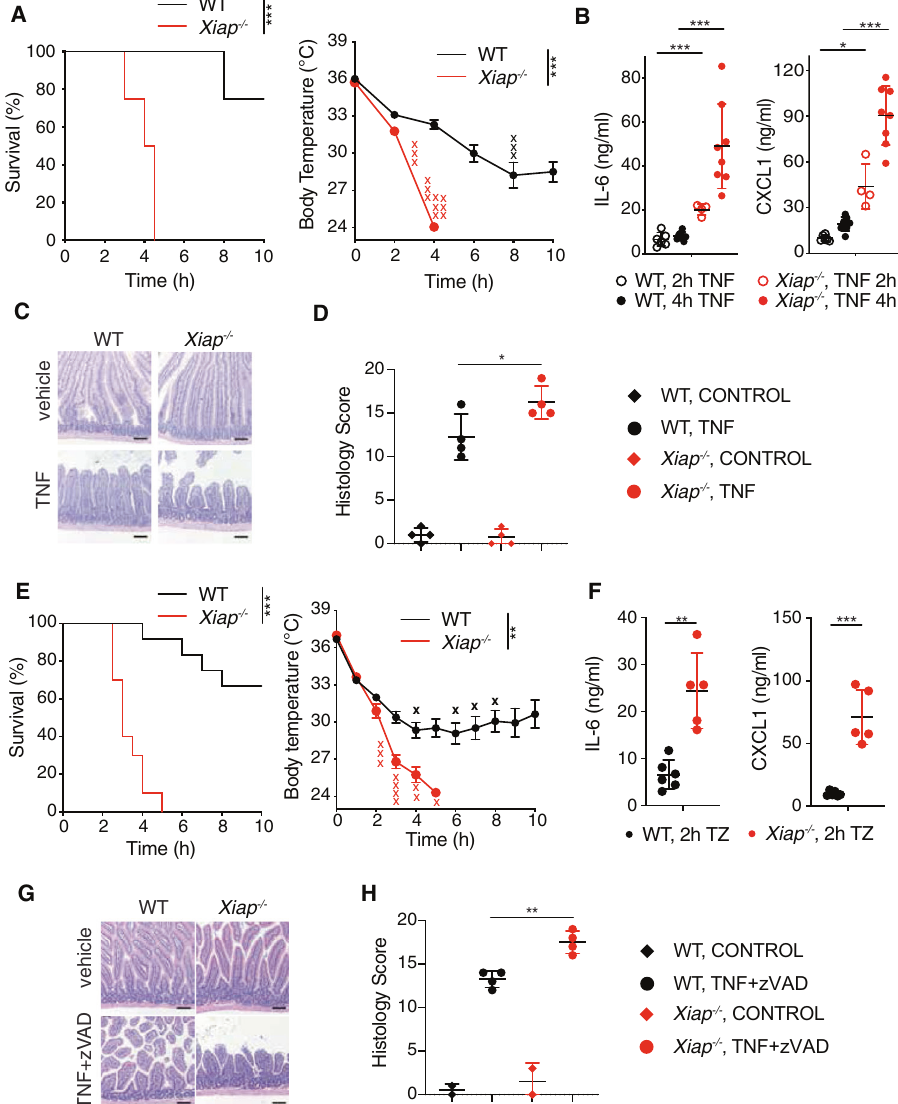
Fig. 2 XIAP deletion sensitizes mice to TNF induced lethality in vivo. A WT ( n = 12) and Xiap − / − ( n = 12) mice were injected with TNF (500 μ g/kg). Survival (left) and body temperature (right) were monitored for 10 h. X indicates animals that had to be euthanized. B Serum levels of indicated cytokines from WT ( n = 6 mice for 2 h and n = 8 for 4 h treatment) and Xiap − / − mice ( n = 4 mice for 2 h and n = 8 for 4 h treatment) post TNF injection were analyzed by Luminex. C , D Hematoxylin and eosin-stained small intestines of WT and XIAP − / − mice 4 h post TNF injection ( C ) and quanti fi cation of the histology score ( D ) ( n = 4 mice per each condition). Size bar = 100 μ m. E WT ( n = 12) and Xiap − / − ( n = 10) mice were injected with TNF (300 μ g/kg) and zVAD-FMK (10 mg/kg). Survival (left) and body temperature (right) were monitored for 10 h. X indicates animals that had to be euthanized. F Serum levels of indicated cytokines from WT ( n = 6) and Xiap − / − ( n = 5) mice 3 h post TNF and zVAD (TZ) injection were analyzed by Luminex. G , H Hematoxylin and eosin-stained small intestines of WT and Xiap − / − mice 3 h post TNF and zVAD injection ( G ) and quanti fi cation of the histology score ( H ) ( n = 2 mice per control groups and n = 4 mice for treatment). Size bar = 100 μ m. In A , E , bars indicate median with standard error, in B , D , F , H mean with standard deviation. * p < 0.05, ** p < 0.01, *** p <